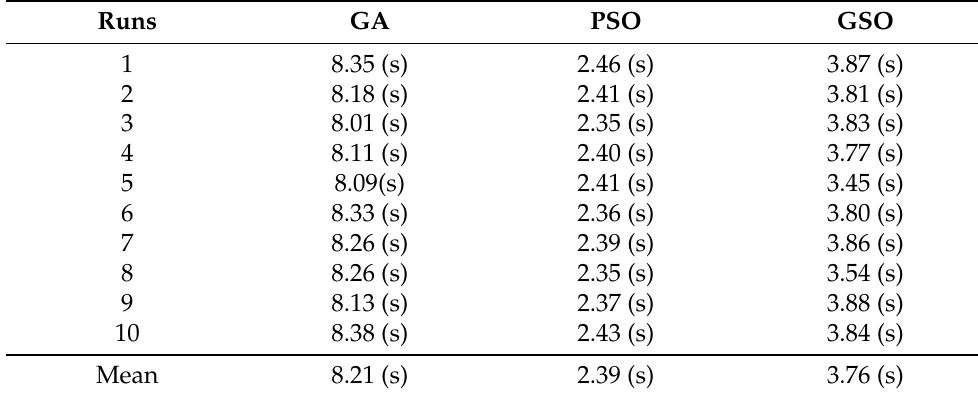
Table 4. Computational time for GA, PSO and GSO in seconds.